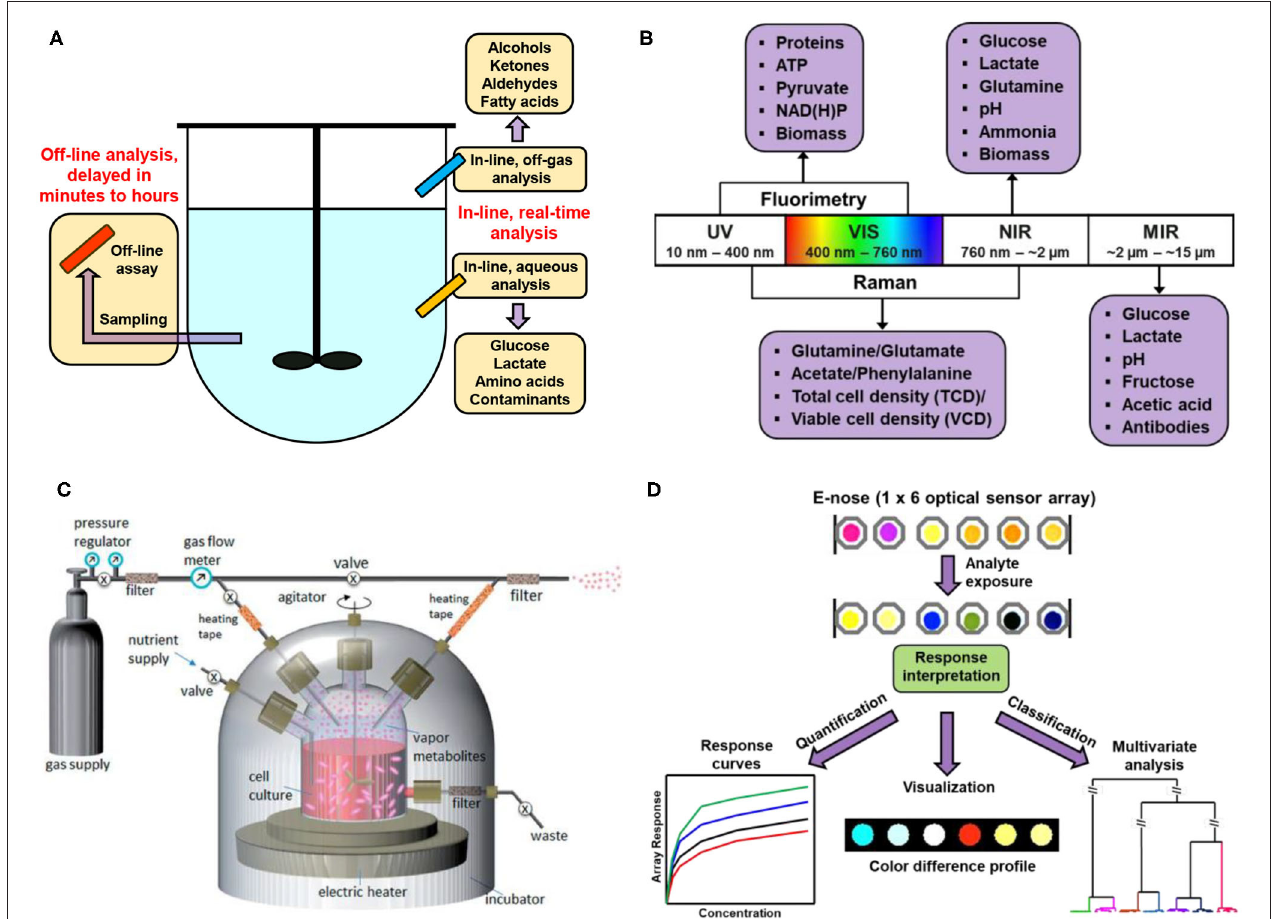
FIGURE 1 | Illustration schemes of the set-ups for biomanufacturing monitoring. (A) Scheme of in-line vs. off-line analysis of bioreactors. (B) Scheme of the mechanism and interpretation of a typical electronic nose (E-nose) system made of optically responsive sensors. (C) Headspace VOC analysis of a growing cell culture in a bioreactor using ambient mass spectrometry. Reproduced with permission from Chingin et al. (2014). Copyright Royal Society of Chemistry 2014. (D) Illustration of electronic noses and pattern